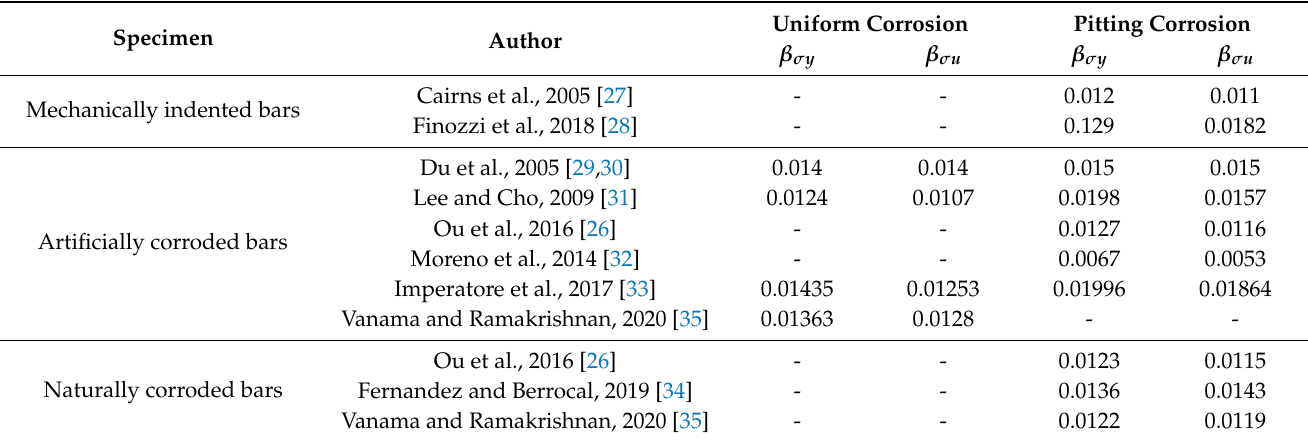
Table 1. Yield and Ultimate Strength correlation coefficients β for degradation laws (EQ. 1) derived for uniform and pitting corrosion.